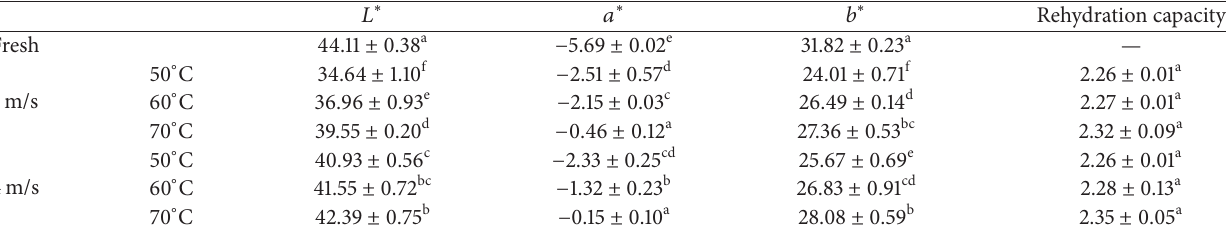
Table 1: Hunter 𝐿 ∗ 𝑎 ∗ 𝑏 ∗ values and rehydration ratio of green peas.